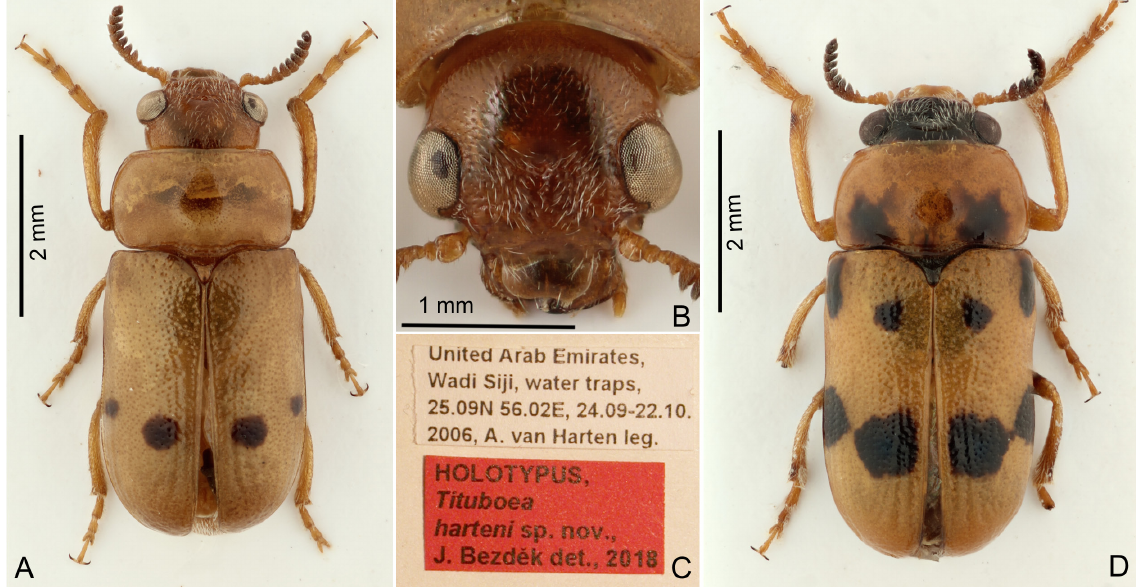
Fig. 6. Tituboea harteni Bezděk sp. nov. A – C . Holotype, ♂, 5.2 mm (NMPC). A . Dorsal view. B . Head. C . Labels. D . Paratype, ♂, 5.3 mm, dorsal view